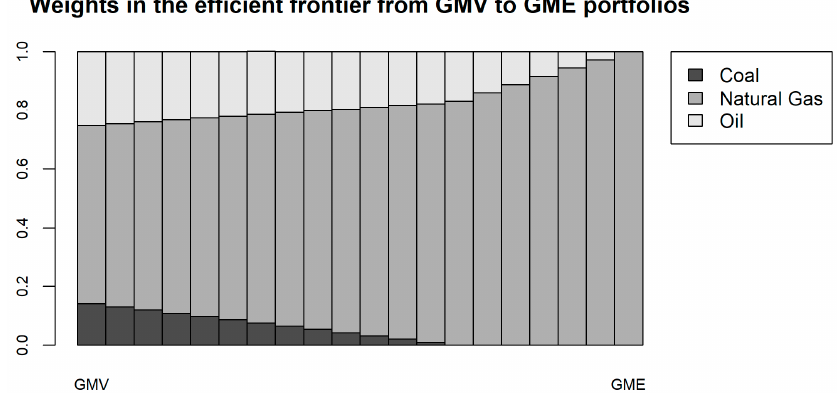
Figure 5. Model adaptation without both carbon capture and storage (CCS) and biomass technologies.